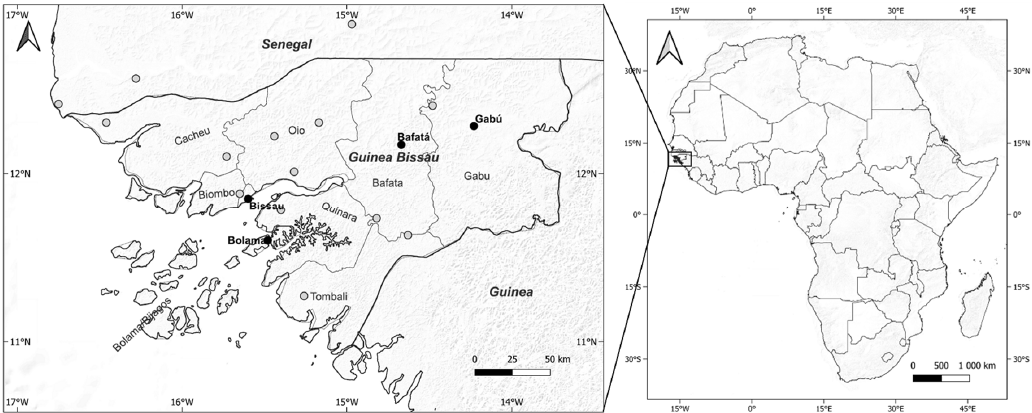
Figure 1. Location of Guinea ‐ Bissau, its administrative regions, and meteorological stations used in this study. In the map on the left, black dots are the stations with longer climatological series (1981–2020), and gray dots are the remaining stations with precipitation data for 2020.